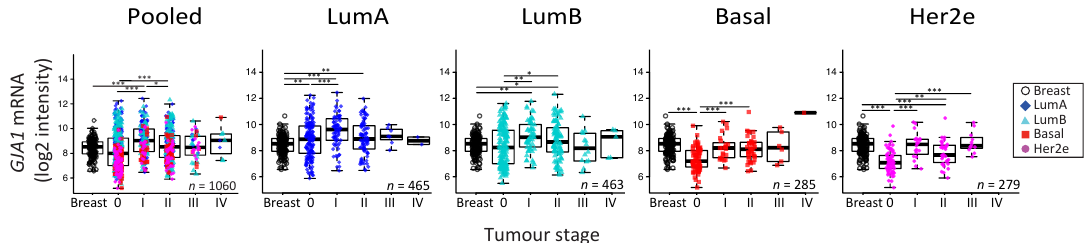
Figure 5. GJA1 mRNA level is dysregulated in clinical samples at the early stages of breast cancer. GJA1 mRNA level for each tumor stage and for normal breast in the Curtis Discovery dataset, either in pooled breast tumors or stratified by intrinsic subtype. In the legend, “Breast” indicates adjacent normal breast tissue. p value: * <0.05; ** <0.01; ***